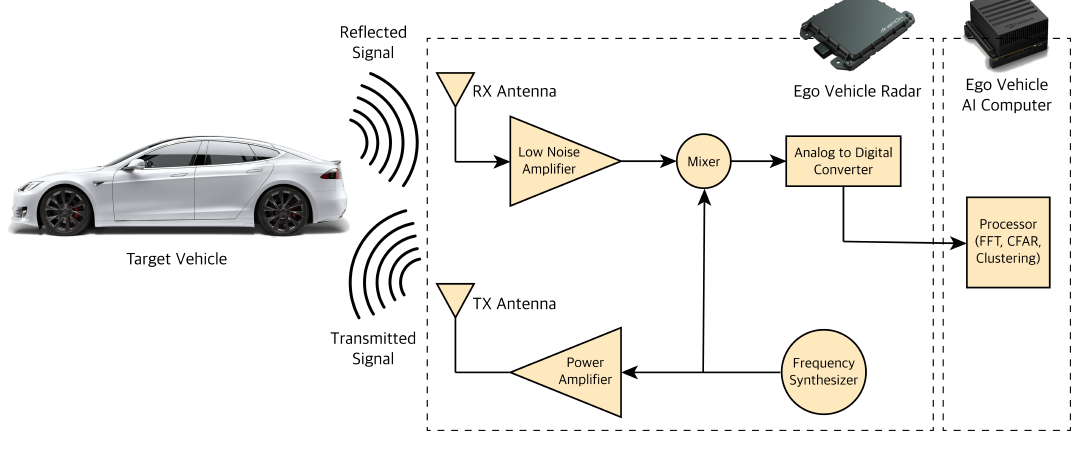
Figure 4. Radar sensor processing